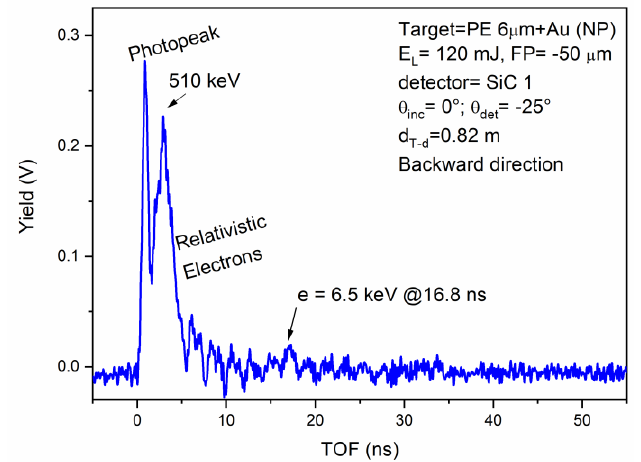
Figure 7. SiC-TOF backward spectrum obtained by irradiating a thin foil of PE with Au NPs, 6 μm thick in TNSA regime, and low laser contrast.